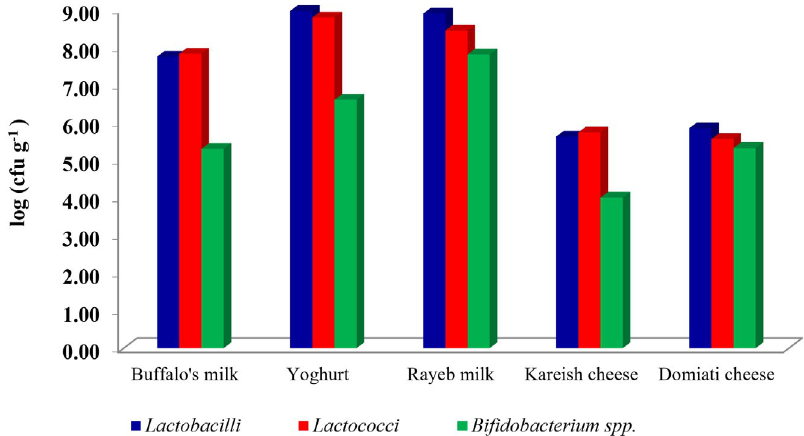
Fig. 1. Log (cfu g/ml-1) of LAB and Bifidobacterium in some dairy and dairy Table 1. LAB isolated from some dairy and dairy products samples Products Lactobacilli Lactococci Bifidobacterium spp. Isolates Strain Isolates Strain Isolates